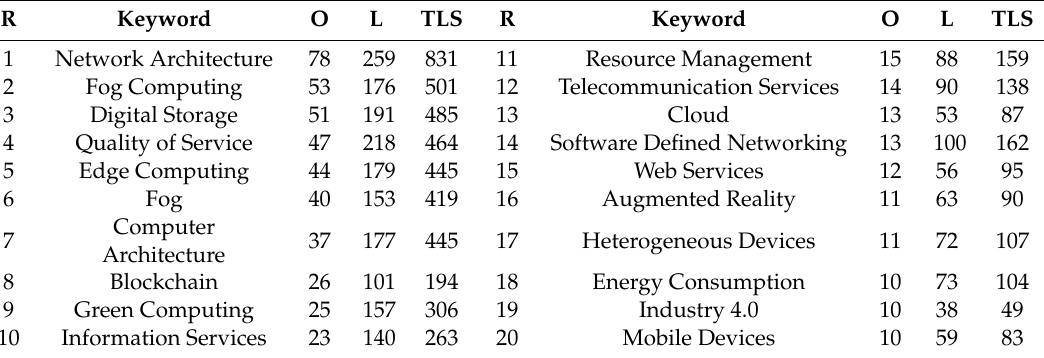
Table 9. Cluster 6. Top 20 keywords (2011–2019).